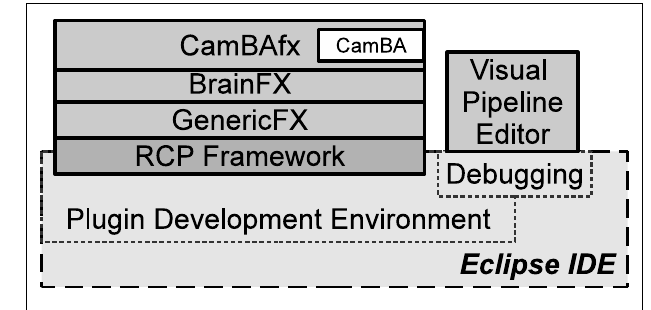
FIGURE 5 | Architecturally, CamBAfx is organized in three layers (Solid boxes): CamBAfx, BrainFX and GenericFX. CamBA is unmodifi ed and completely contained inside a plug-in in the CamBAfx layer. They are all built on top of the Eclipse RCP Framework and developed inside Eclipse Integrated Development Environment’s (IDE) Plug-in Development Environment (dashed boxes). CamBAfx extends the Eclipse IDE with a Visual Pipeline Editor to visualize the pipelines during their development and